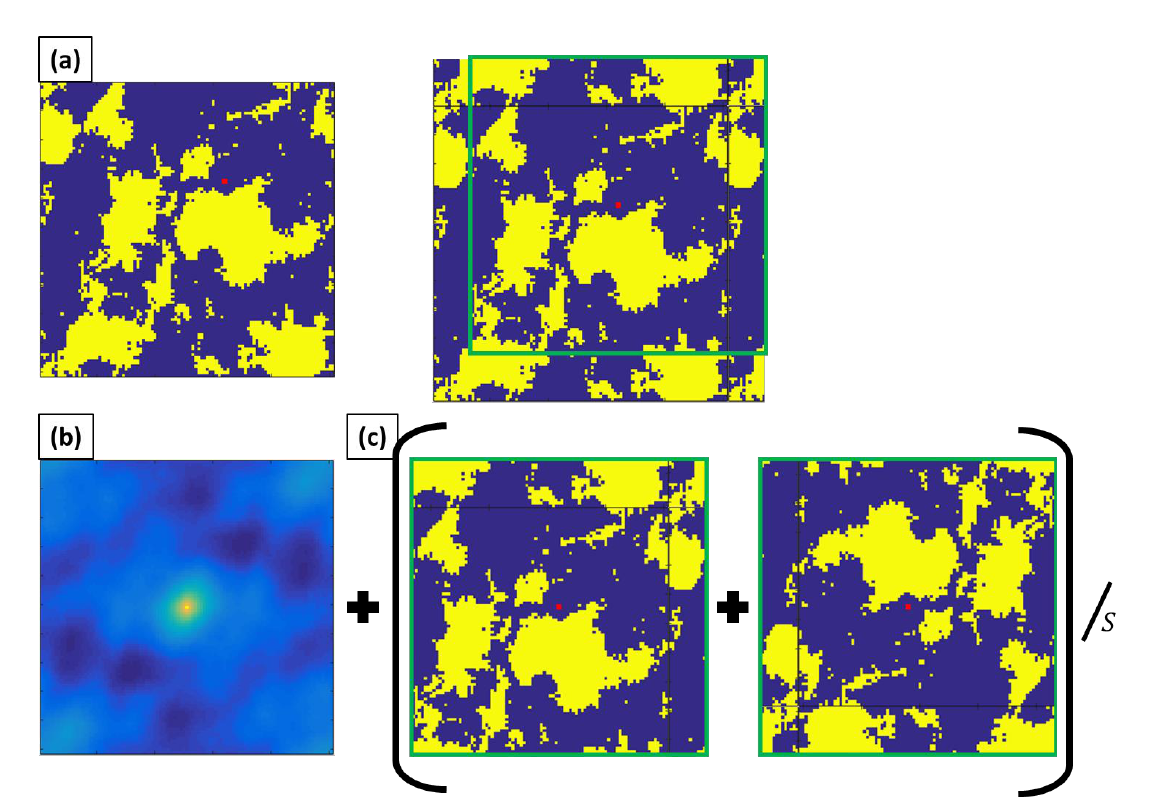
Figure 5. Illustration of the update of the autocorrelations with the change in the local state of a single pixel. ( a ) The initial microstructure with the pixel to be changed shown in red. ( b ) Yellow–yellow autocorrelation. ( c ) The correction of the autocorrelation as a result of the change made to the red pixel.